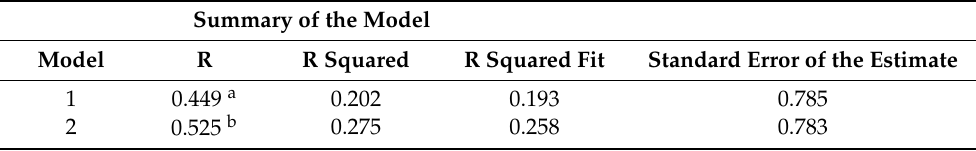
Table 3. Summary of the model. Source: own elaboration.